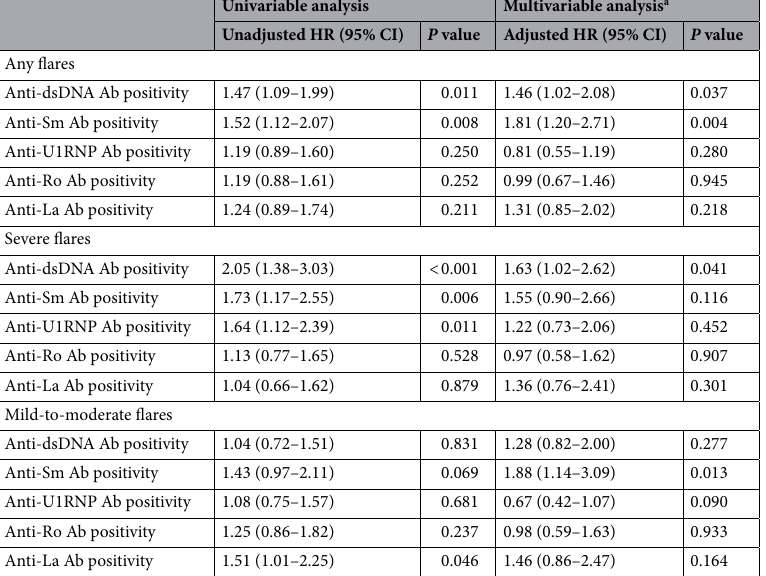
Table 3. Risk of flares according to the positivity of each autoantibody. HR hazard ratio; CI confidence interval; ds double-stranded; Ab antibody. a Multivariable analysis adjusted for age, sex, positivity of other autoantibodies, levels of complements, renal involvement, SLEDAI-2 K, and use of hydroxychloroquine and immunosuppressants during observation